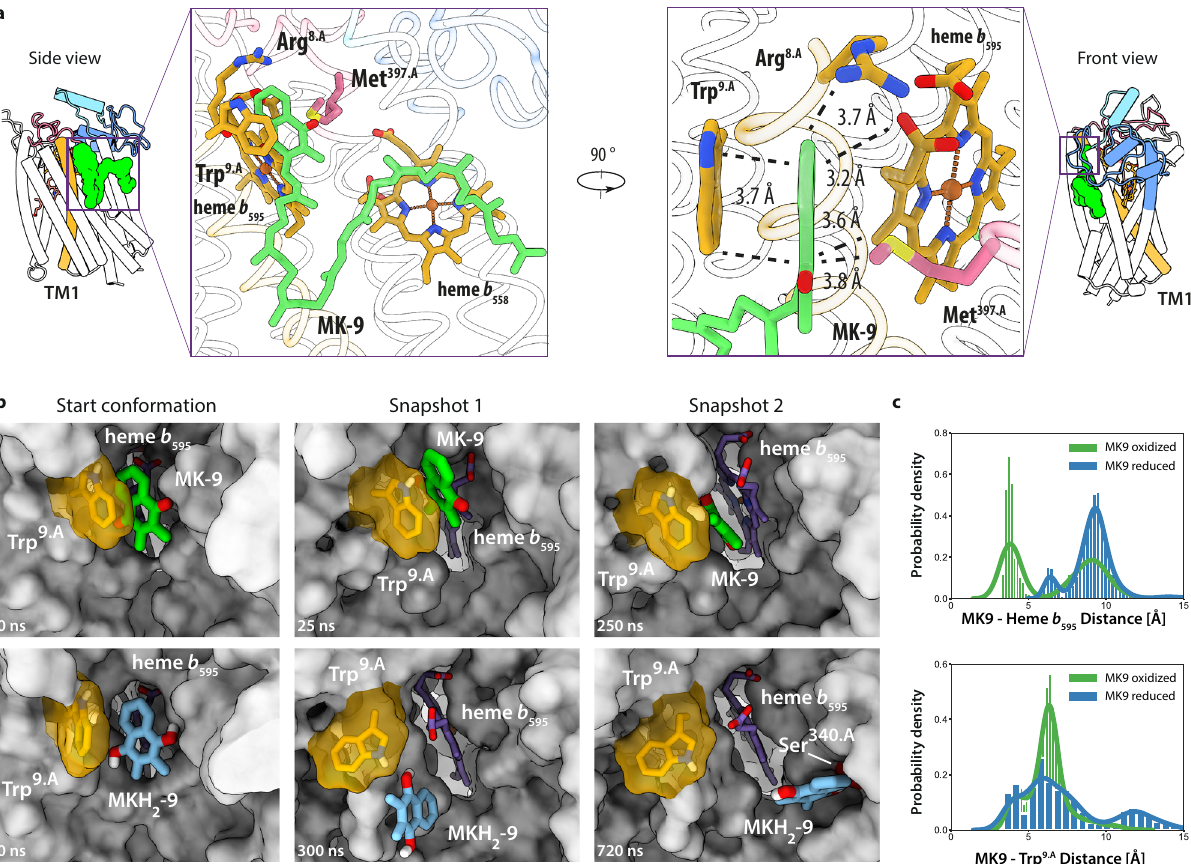
Fig. 4 Allosteric MK-9 binding site of cyt. bd Mtb . a Left: Side view closeup of the MK-9 binding pocket composed of residues from TMH1, TMH9, and the heme b 595 porphyrin scaffold. Right: Front view closeup of the MK-9 binding pocket composed of residues from TMH1, TMH9, and the heme b 595 porphyrin scaffold. Van-der-Waals interaction distances are indicated. b Representative snapshots of different MK-9 binding modes during 2 × 750 ns MD simulations in reduced and oxidized states. For simplicity, hydrocarbon chains of MK-9 molecules are not shown. c Distance histograms between MK-9 and heme b 595 (Top), and MK-9 and Trp 9.A (Bottom) during MD simulations. Blue data plots indicate a simulation setup with reduced MK-9. Green data plots indicate a simulation setup with oxidized MK-9. Oxidized MK-9, green; reduced MK-9, blue; heme b 595 , purple; Trp 9.A ,